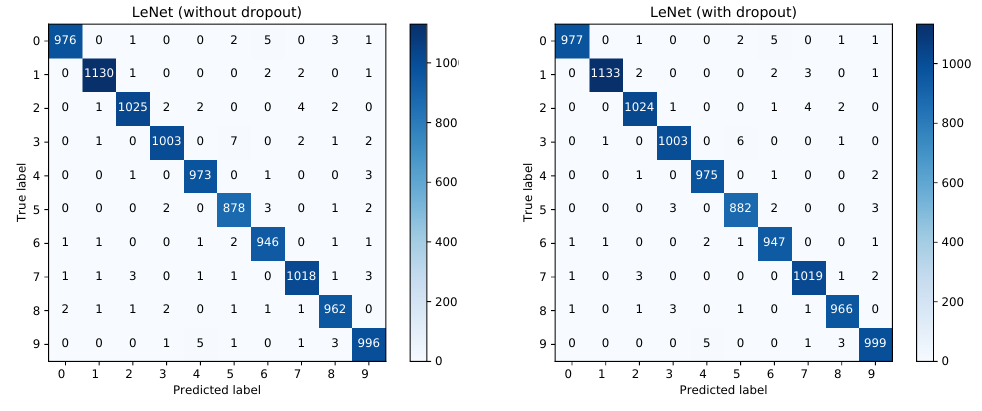
Figure 2. Confusion matrices for the frequentist LeNet without and with